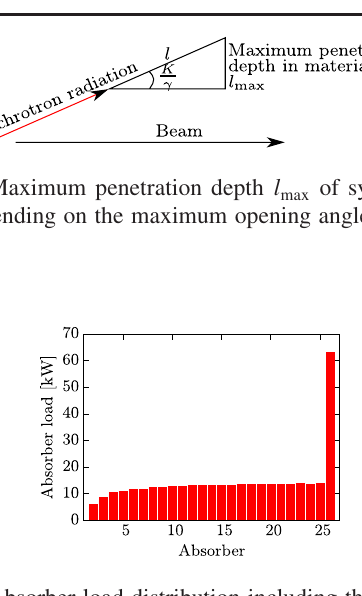
FIG. 15. Absorber load distribution including the dump at the end of the straight section.